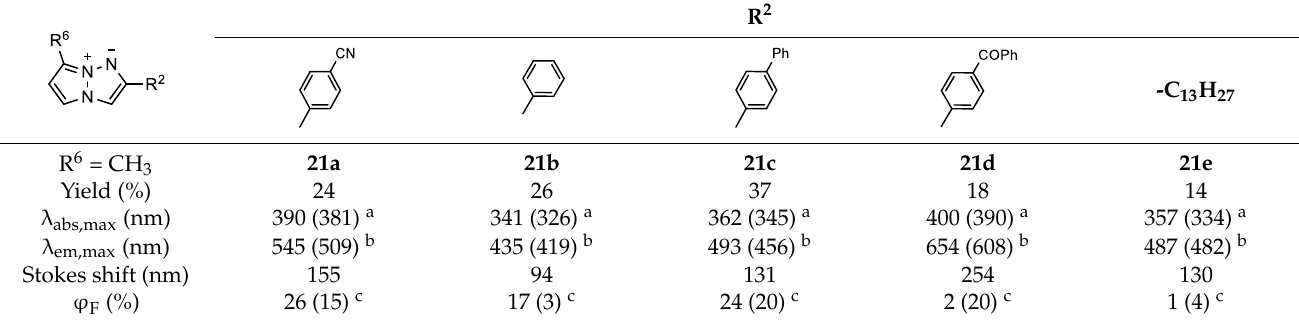
a Absorption maximum of the corresponding 6-unsubstituted analog. b Fluorescence maximum of the corresponding 6-unsubstituted analog. c Quantum yield of corresponding to the 6-unsubstituted